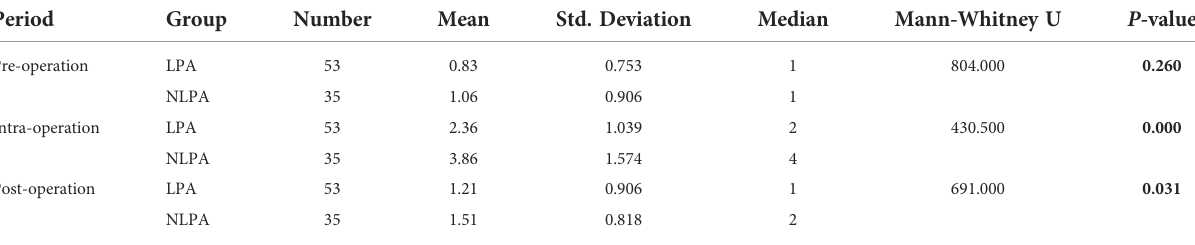
TABLE 3 Differences of VAS scores between the two groups.